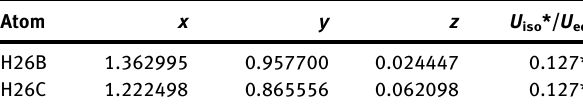
Table  : Fractional atomic coordinates and isotropic or equivalent isotropic displacement parameters (Å 